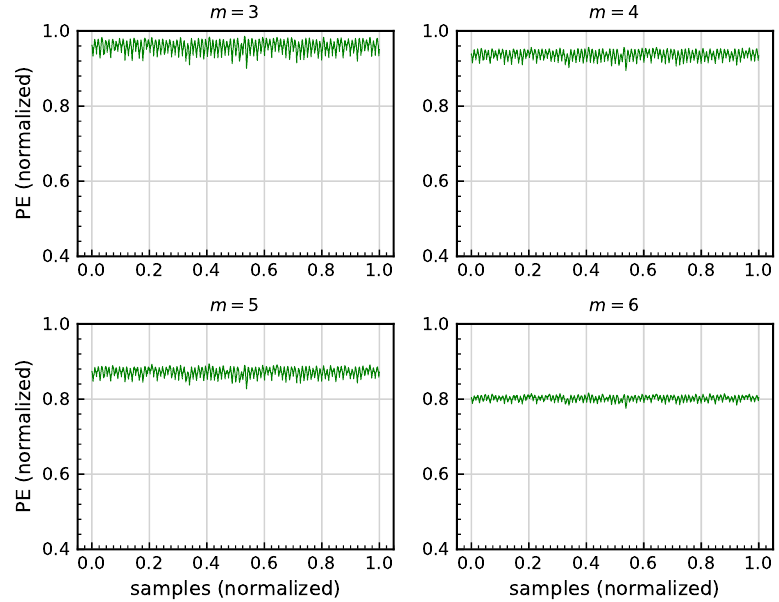
Figure 12. Comparison of the permutation entropy PerEn signal calculated for 30 s of a large raceway shaft washer damage scenario RL signal, with fixed W s =